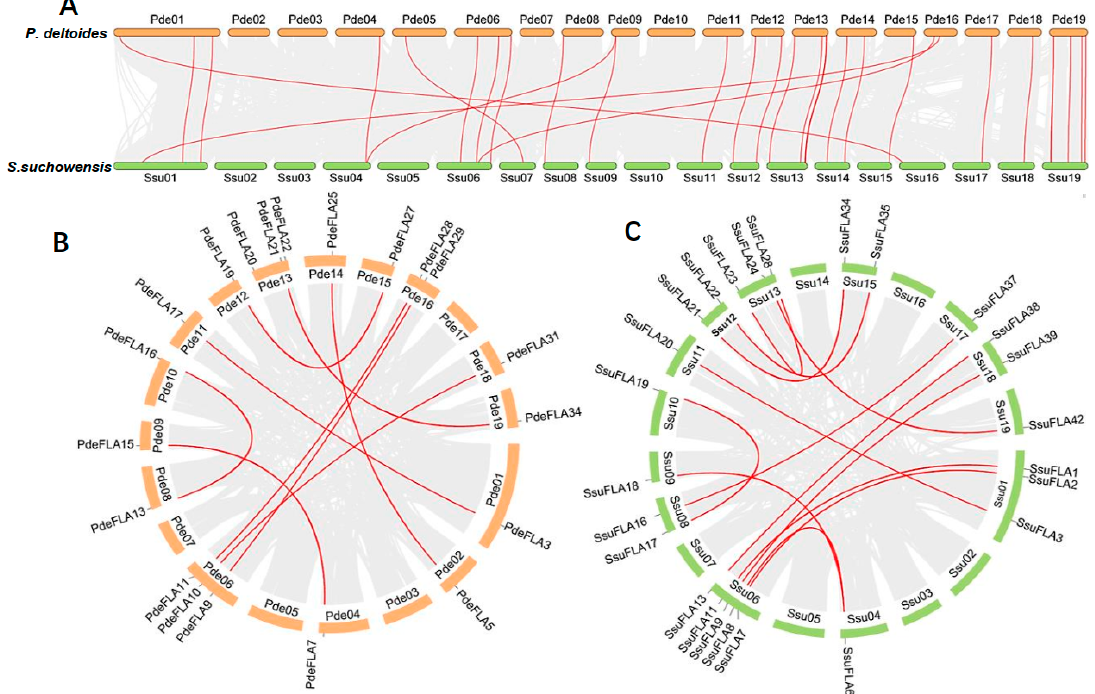
Figure 2. Synteny analysis of FLA genes. Segmental duplication of FLA gene pairs in P. deltoides ( A ) and S. suchowensis ( B ), with red lines indicating the correspondence of duplicated genes. ( C ) Gene duplication and synteny relationship of FLA genes between P. deltoides and S. suchowensis . The red lines indicate the syntenic FLA gene pairs, and the light gray indicates collinear blocks.